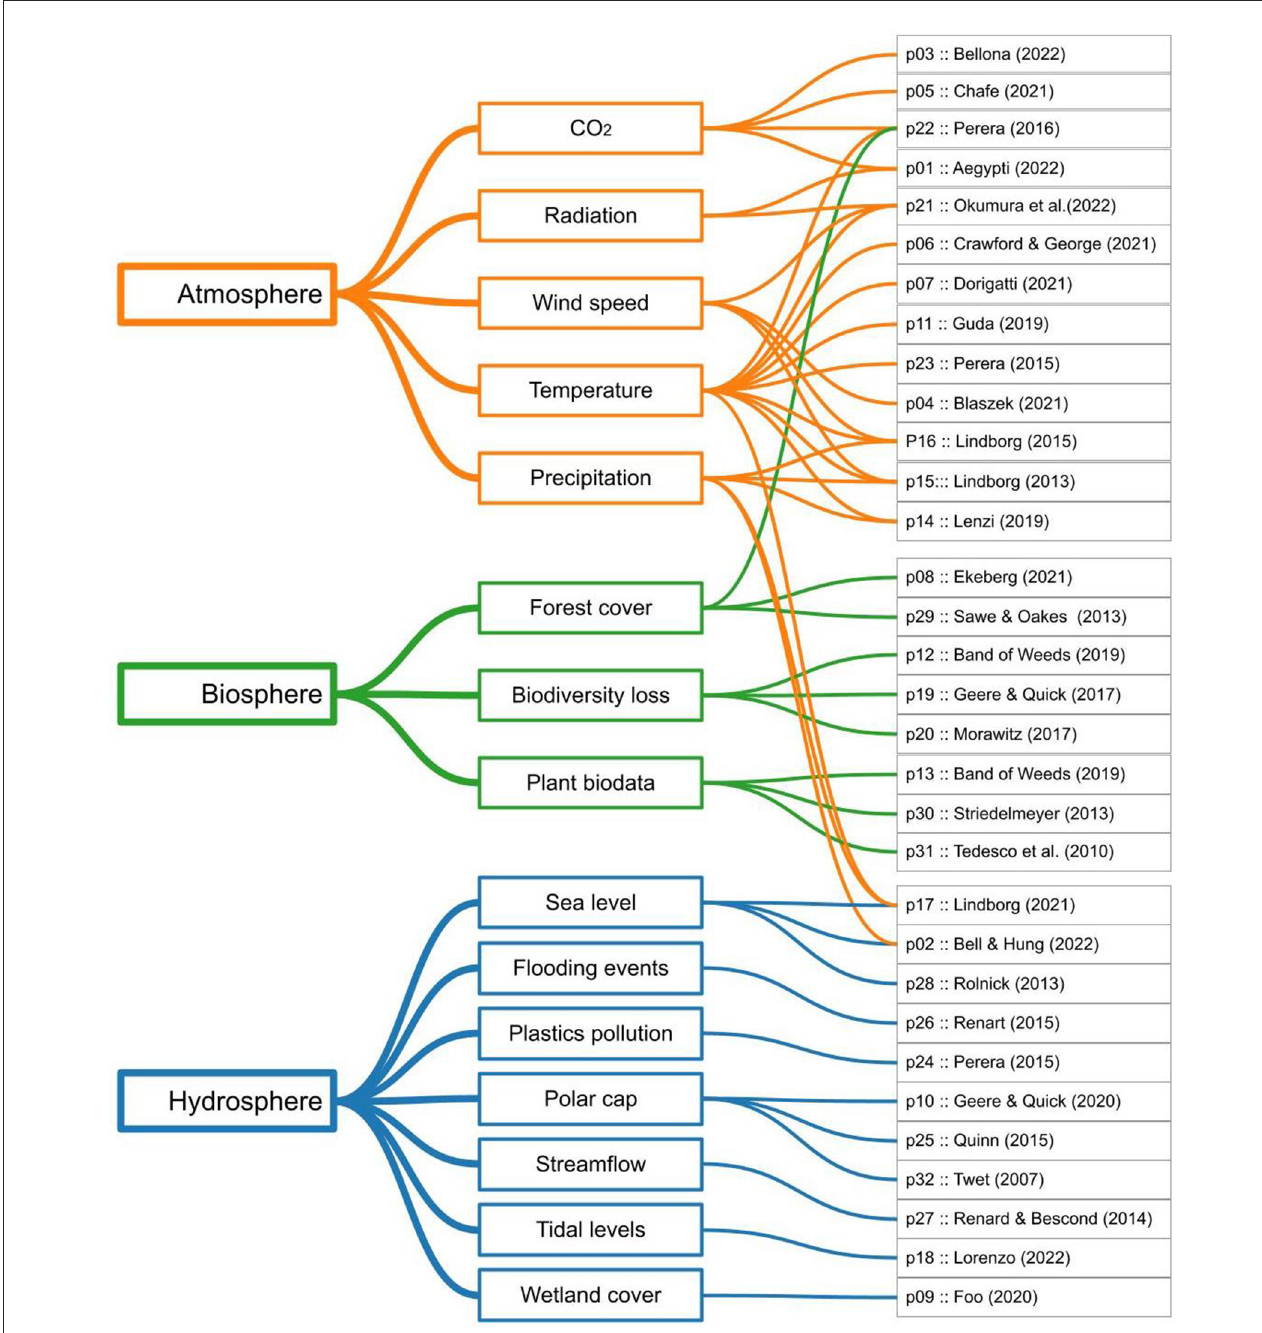
FIGURE1 Hierarchical overview of the 32 projects, classified under 3 topics (data provenance) and 15 subtopics (data